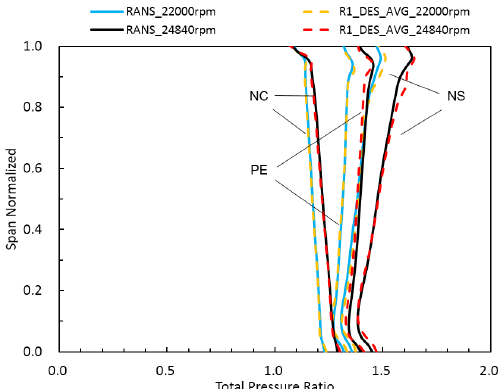
Figure 6. Comparison of total pressure ratio distribution.